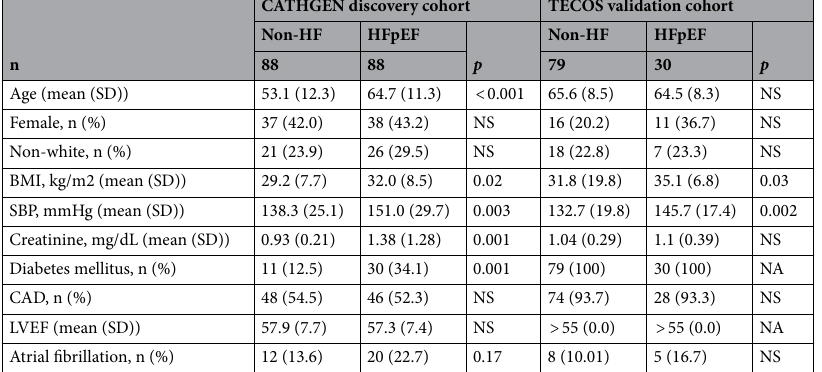
Table 1. Participant Characteristics in CATHGEN discovery cohort and TECOS validation cohort. Values represent mean and standard deviation for continuous variables; body mass index (BMI); coronary artery disease (CAD); left ventricular ejection fraction (LVEF); not significant (NS); not applicable (NA); systolic blood pressure (SBP).